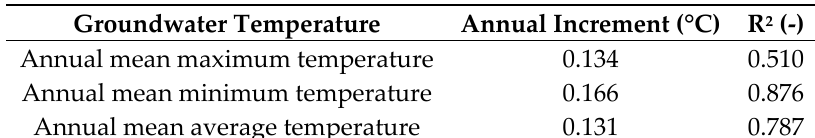
Figure 3. ( a ) Groundwater temperatures recorded in the study area from 2004 to 2016 (black dots) with linear fit and the corresponding 95% confidence intervals plotted; ( b ) Annual mean minimum groundwater temperatures (black dots) and annual mean air temperatures (black triangles) recorded in the study area from 2004 to 2016 with linear fit and the corresponding 95% confidence intervals plotted. . Table 2. Annual increments of mean maximum, minimum and average air temperatures, with their relative R 2 .